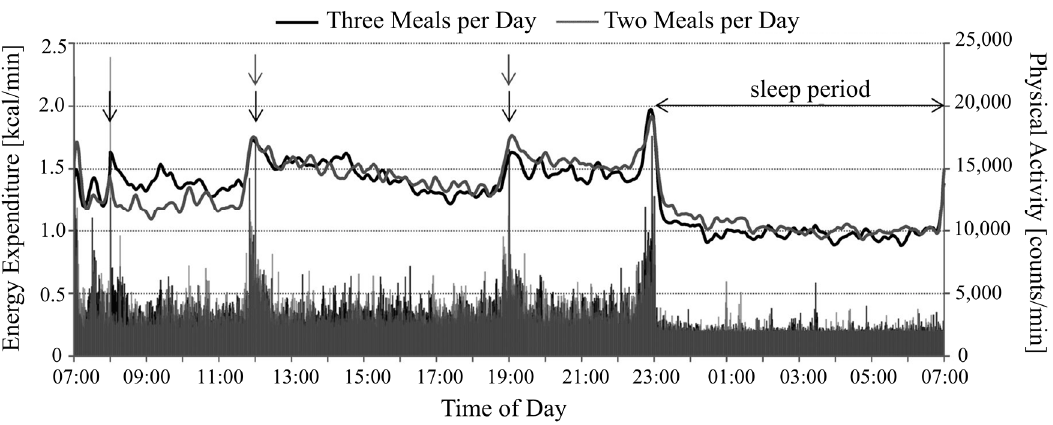
Figure 2. EE and physical activity measured under conditions of two and three meals per day. Arrows indicate meal times. Adapted from [107].